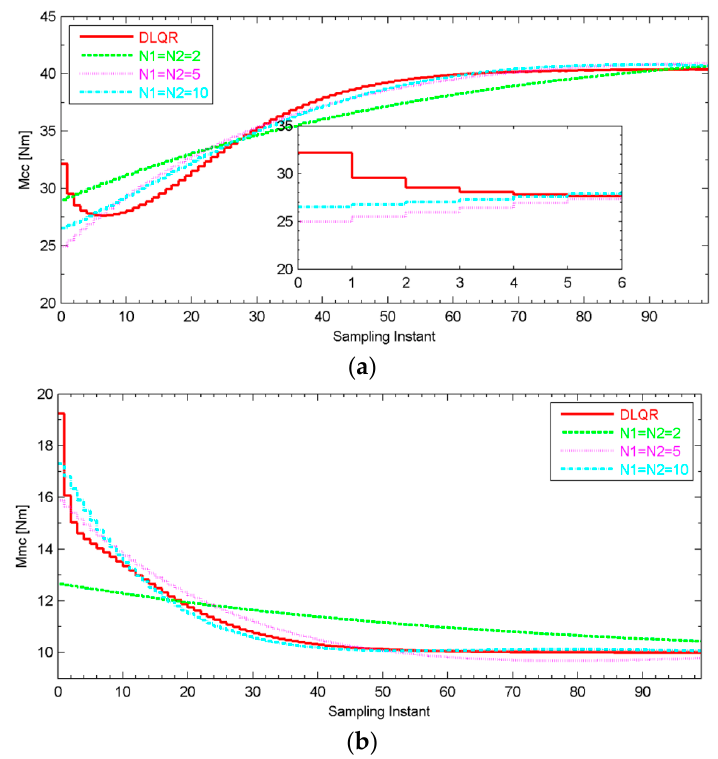
Figure 7. Difference between the optimum trajectories in the case of (cid:1853) (cid:2869) (cid:3404) (cid:1853) (cid:2870) (cid:3404) 0.9 . The sampling interval is ten milliseconds. ( a ) Difference between the optimum trajectories of the clutch torque command (cid:1839) (cid:3030)(cid:3030) ; ( b ) Difference between the optimum trajectories of the motor output torque command (cid:1839) (cid:3040)(cid:3030) .